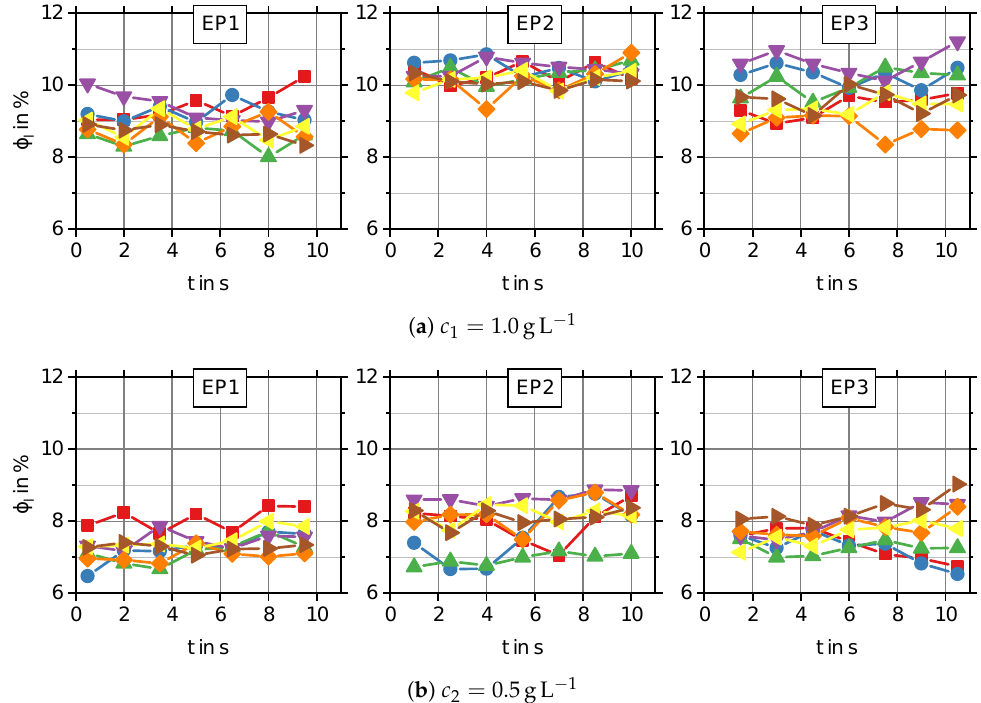
Figure 3. Liquid fraction φ l of the foam for the two different SDS concentrations, determined from the electrical conductivity between the left (EP1), middle (EP2), and right electrode pair (EP3), measured in several measurement runs over a measurement time of 10s each. Liquid fraction data from EP1, EP2, and EP3 in the same measurement run are indicated by the same colour and